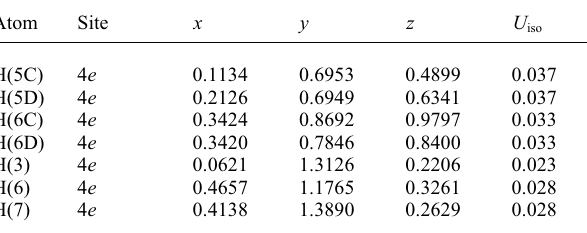
Table 2. Atomic coordinates and displacement parameters (in Å 2 )